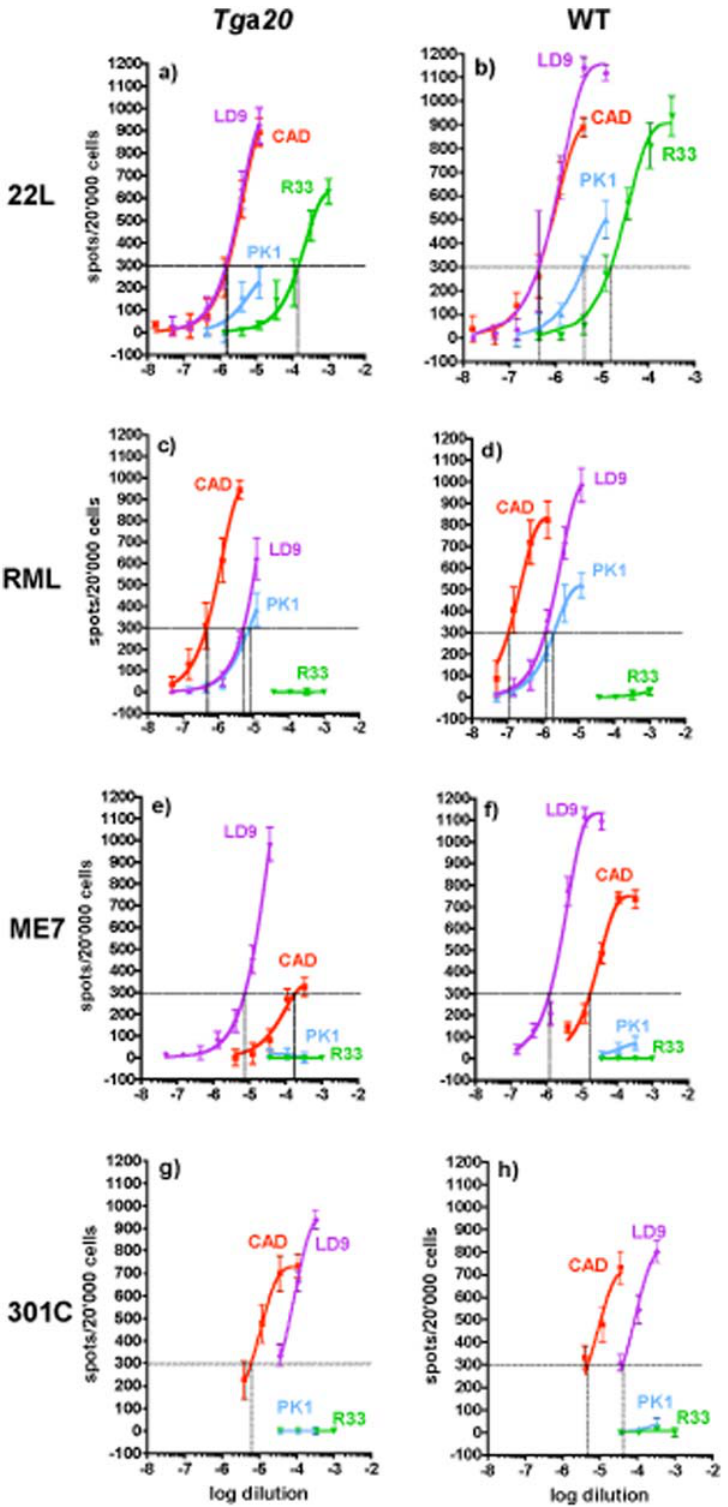
Figure 3. The Cell Panel Assay of four prion strains propagated in Tg a 20 or wild-type mice results in similar relative Response Indices on four cell lines. CAD5 (red), PK1 (blue), R33 (green) and LD9 (violet) cells were exposed to 1:3 serial dilutions of 0.1% brain homogenates infected with 22L (a,b), RML (c,d), ME7 (e,f) or 301C (g,h) propagated in Tg a 20 mice (a,c,e,g) or wild-type mice (b, f, h, C57BL/6; d, CD1). The number of PrP Sc -positive cells (‘‘spots’’) is plotted against log[dilution] of the brain homogenate. The Response Index (RI 1.5%/3 ) of a cell line for a prion strain (vertical dotted line) is the concentration (reciprocal of the homogenate dilution) that yields 300 spots per 20’000 cells (1.5% PrP Sc -positive cells) after the 3 rd split (horizontal dotted line). The ‘‘RI ratio’’ of a strain is the RI on a cell line relative to that on LD9; it was very similar for each strain regardless of whether it was propagated in wild-type or Tg a 20 mice (see Table S1 for RI values).